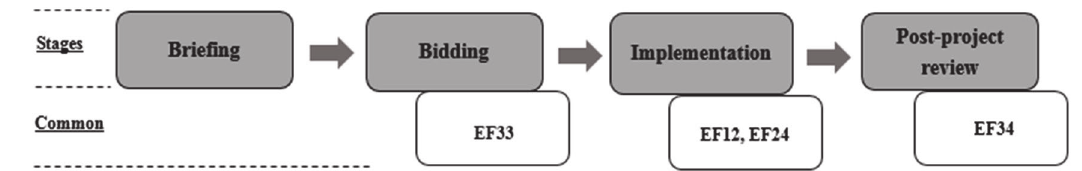
Figure 3. Common key factors of the competition